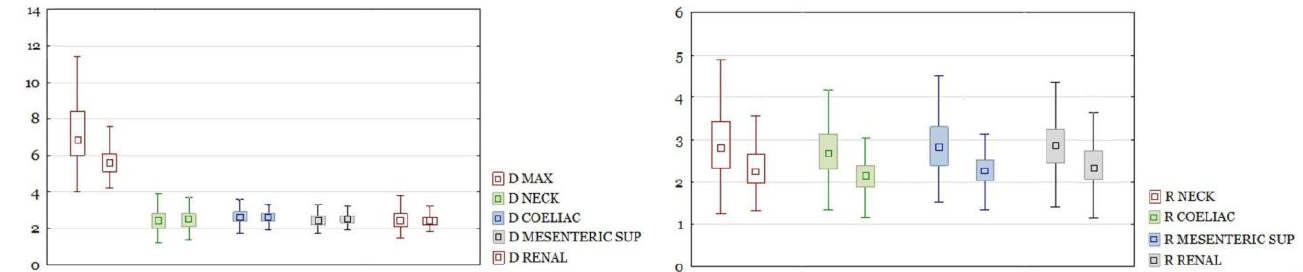
Figure 3. On the left, a comparison of diameters of the aorta at different levels and AAA diameters between ruptured and unruptured aneurysms in the whole cohort. Diameters in cm. Boxplots are shown in pairs. The left one is diameter for ruptured, the right one is diameter for unruptured aneurysms. Only D MAX difference is significant with p < 0.05. On the right, a comparison of ratios between ruptured and unruptured aneurysms. Boxplots are shown in pairs. The left one is ratio for ruptured, the right one is ratio for unruptured aneurysms. All differences significant at p < 0.05.